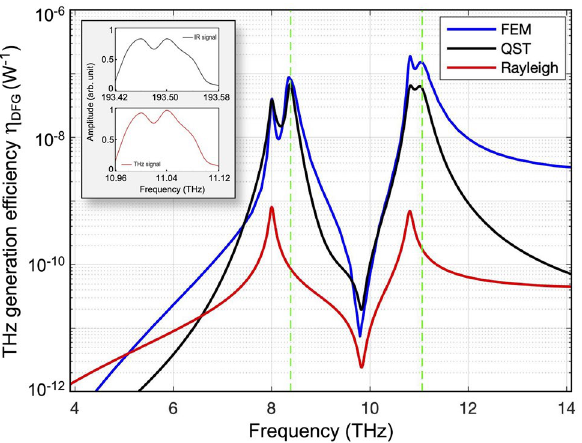
Figure 4. Conversion efficiency for THz generation by DFG in the proposed AlGaAs nanoantenna, evaluated from FEM numerical analysis (blue), and QST reduced model of Eq. (4) with (black) or without (red) contribution from TO phonon permittivity. The inset shows the negligible spectral distorsion introduced by the proposed